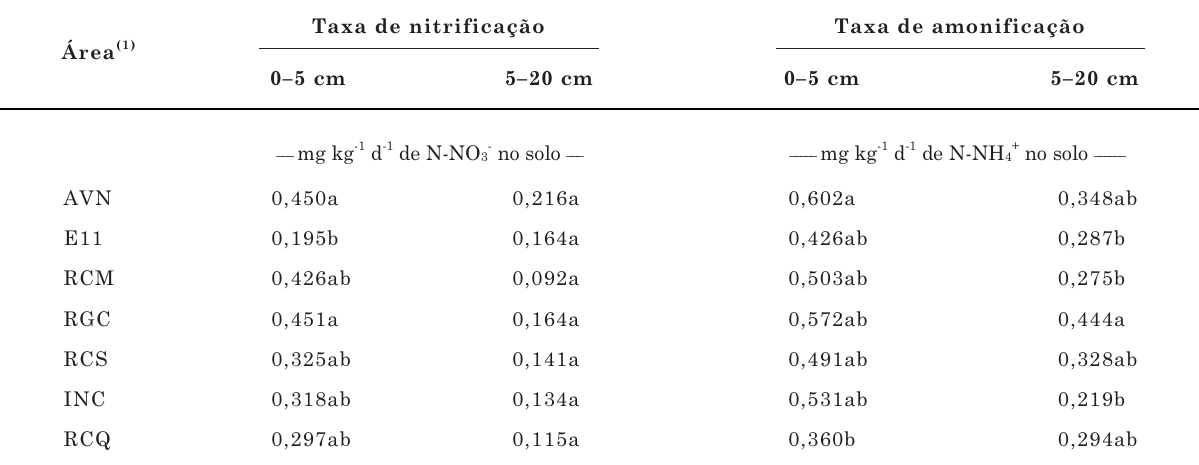
(1) AVN: área de vegetação natural de mata secundária, E11: área onde não foi realizado o corte das árvores do primeiro ciclo (eucalipto com 11 anos), RCM: reforma sem a remoção de resíduos (cultivo mínimo), RGC: reforma com remoção dos restos culturais (galhos e cascas), RCS: reforma com remoção dos restos culturais e da serapilheira, INC: reforma com incorporação de todos os resíduos com grade e RCQ: reforma com a queima de todos os resíduos. Médias seguidas pela mesma letra, na coluna, não diferem entre si pelo teste de Tukey a 5